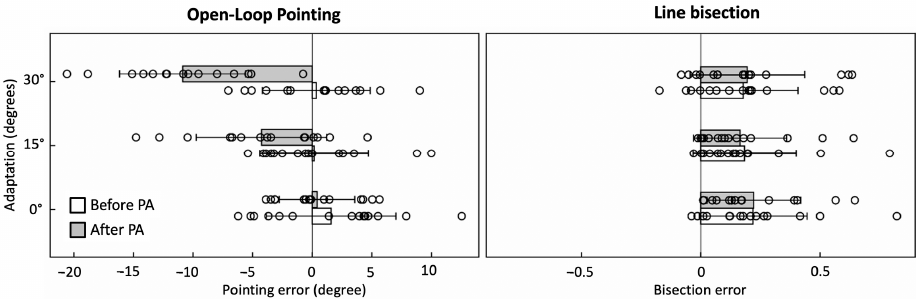
Figure 4. Adaptation effects of 15 patients with left spatial neglect ( left ), and absence of transfer to line bisection ( right ) [adapted from Ref. [82], 2022, Taylor & Francis] .